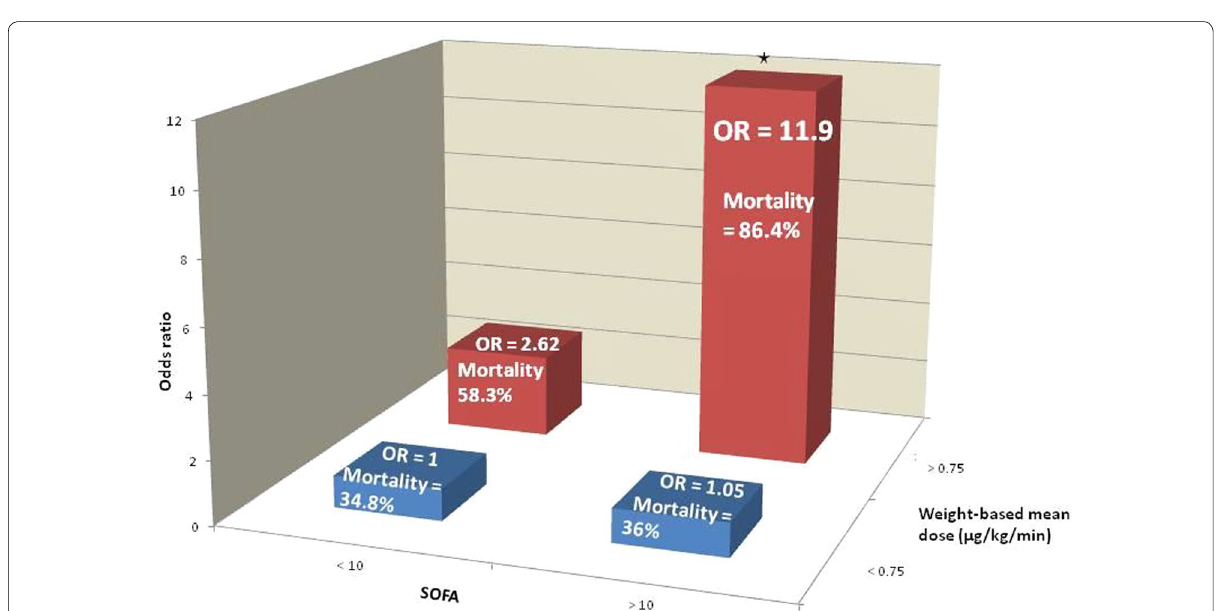
Fig. 5 Correlation between WMD